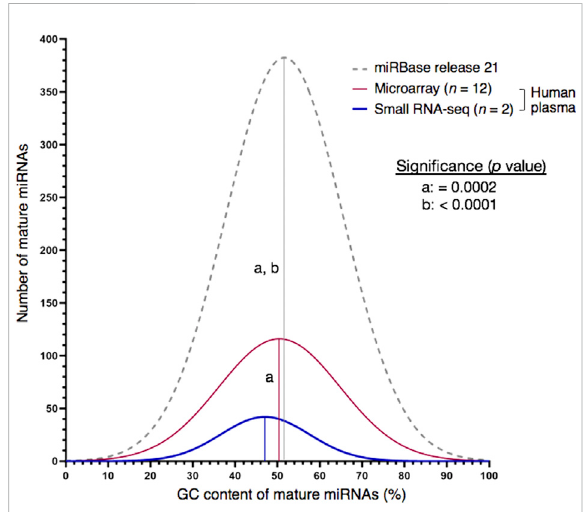
FIGURE 1 Choice of high-throughput pro fi ling technique may cause detectionbiasformiRNAtargetswithveryhighGCcontent( ≥ 75%). Whereas the GC plot of miRNAs contained in the